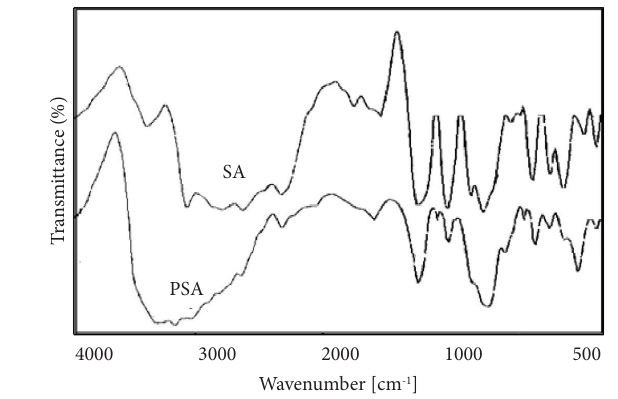
Figure 8: Te infrared spectra of SA and PSA. Table 4: Infrared absorption bands of SA and